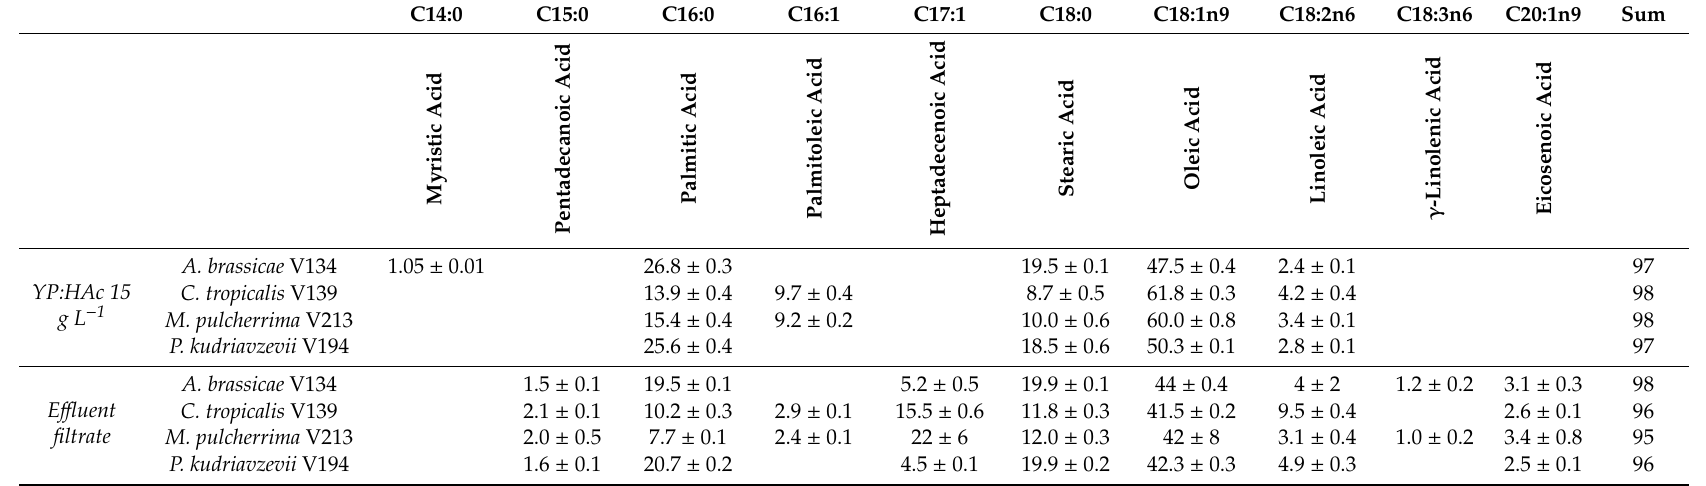
Table 3. Long-chain fatty acid profiles (%) obtained for the four yeast isolates after 120 h of growth in YP:HAc 15 g L − 1 and in the e ffl uent filtrate. Results represent mean of triplicates ± standard